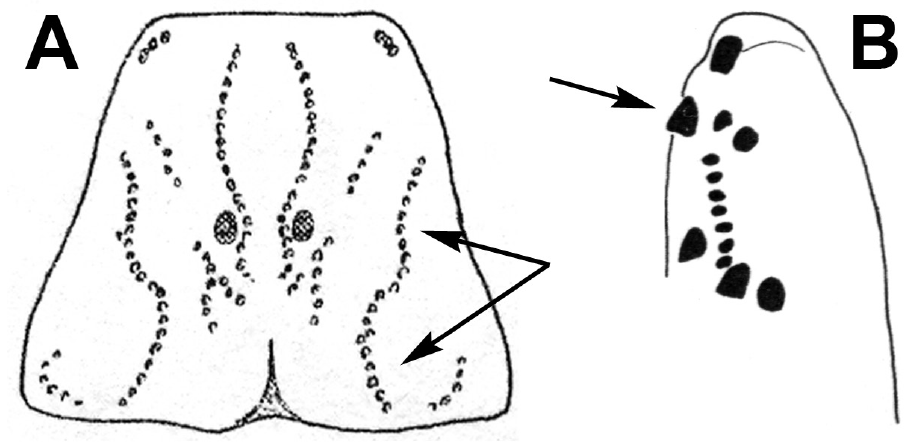
Figure 4. The two key morphological diagnostic characters of the genus Buthus . A- Prosoma carapace with lyra-shaped keels (Hjelle 1990); B - Tip of pedipalp movable finger highlighting the three distal granules (distal denticle not included) (Lourenço 2002).